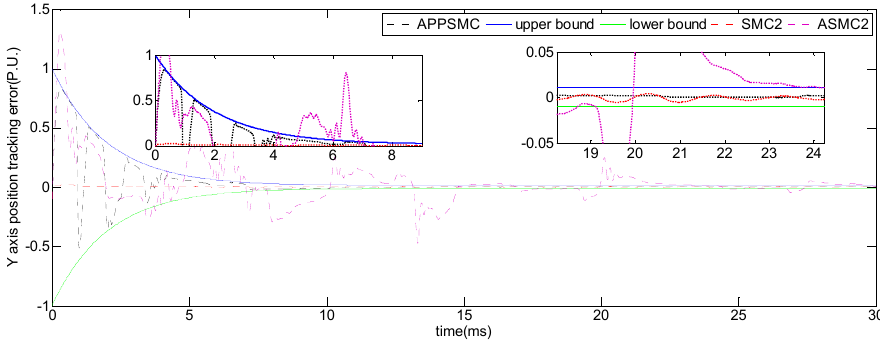
Figure 11. Y axis tracking error comparisons of SMC2, ASMC2, and APPSMC.